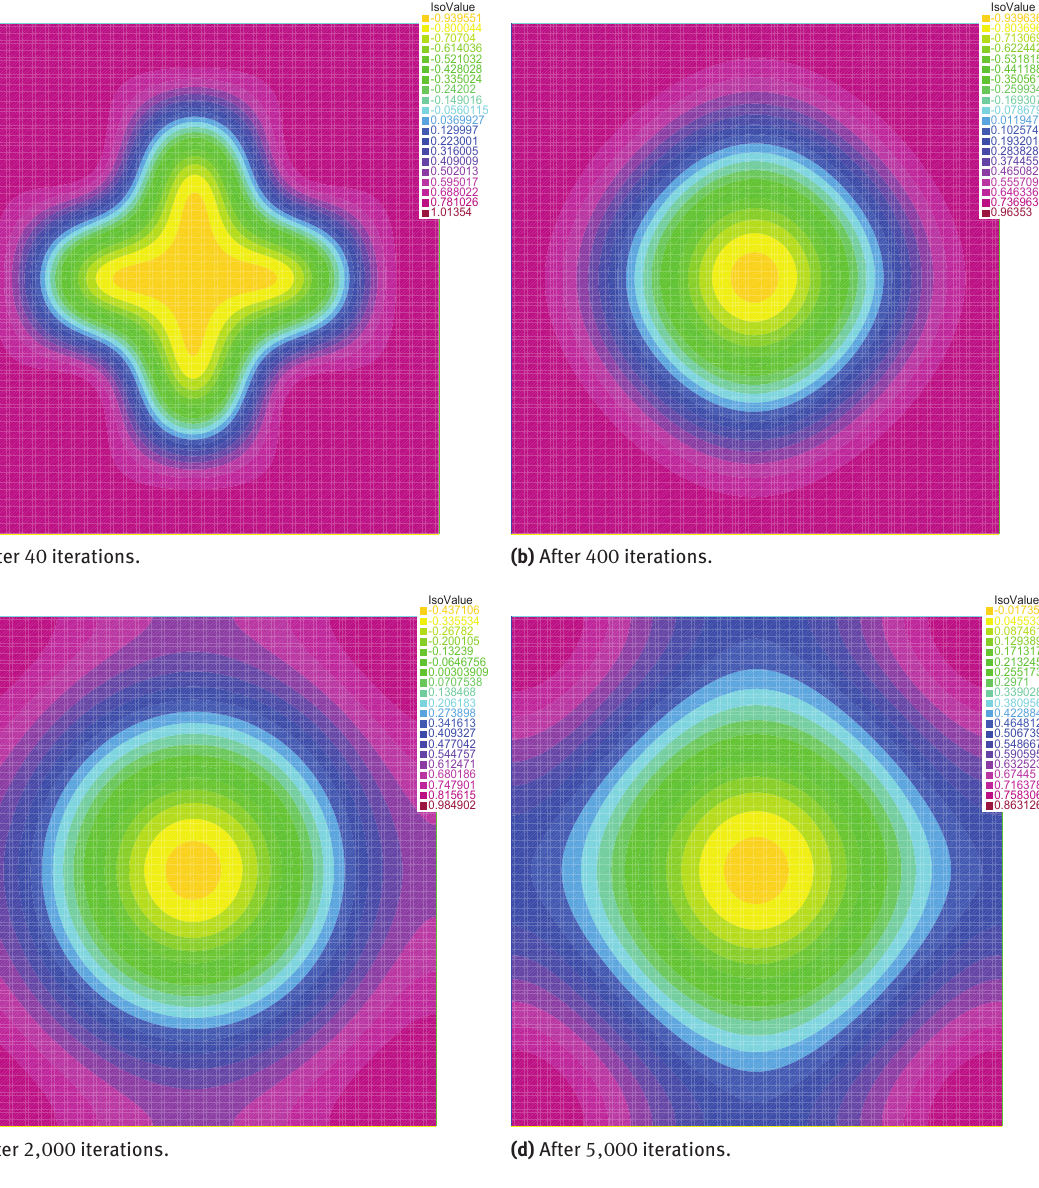
Figure 5: Results for k = 2, dt = 10 − 7